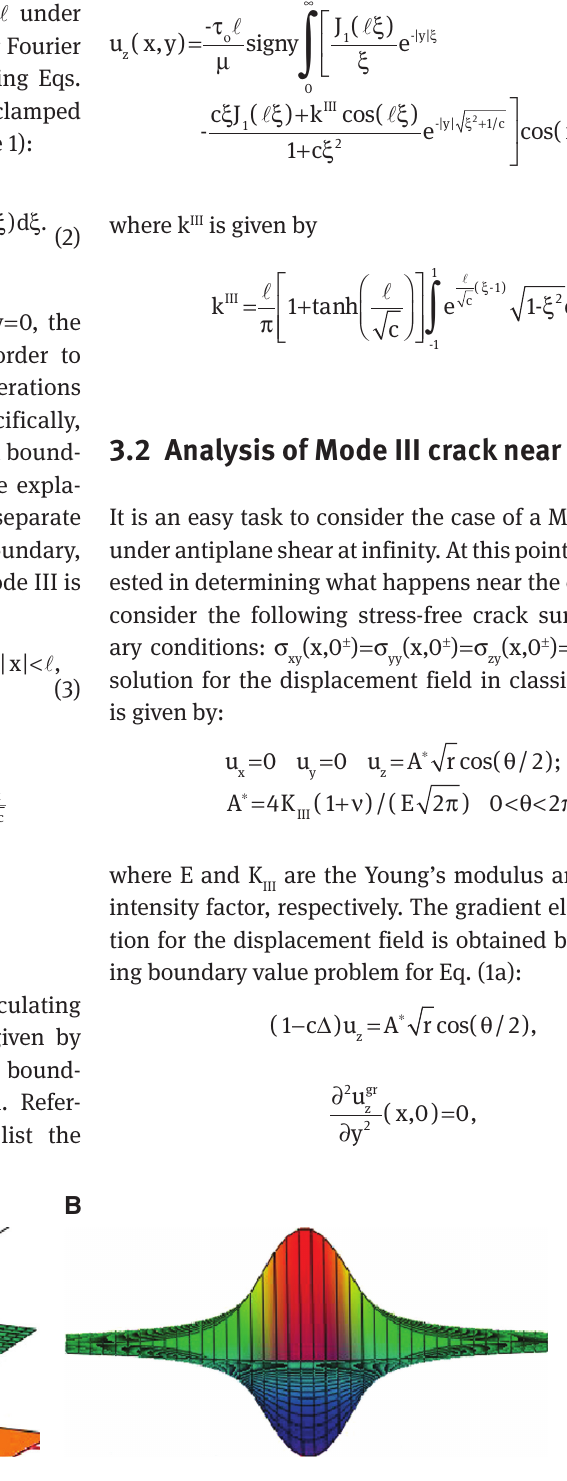
l / μ . (B) Plot of Eq. (2) from another perspective which denotes its unclamped crack tip < 0 in units of - τ o o